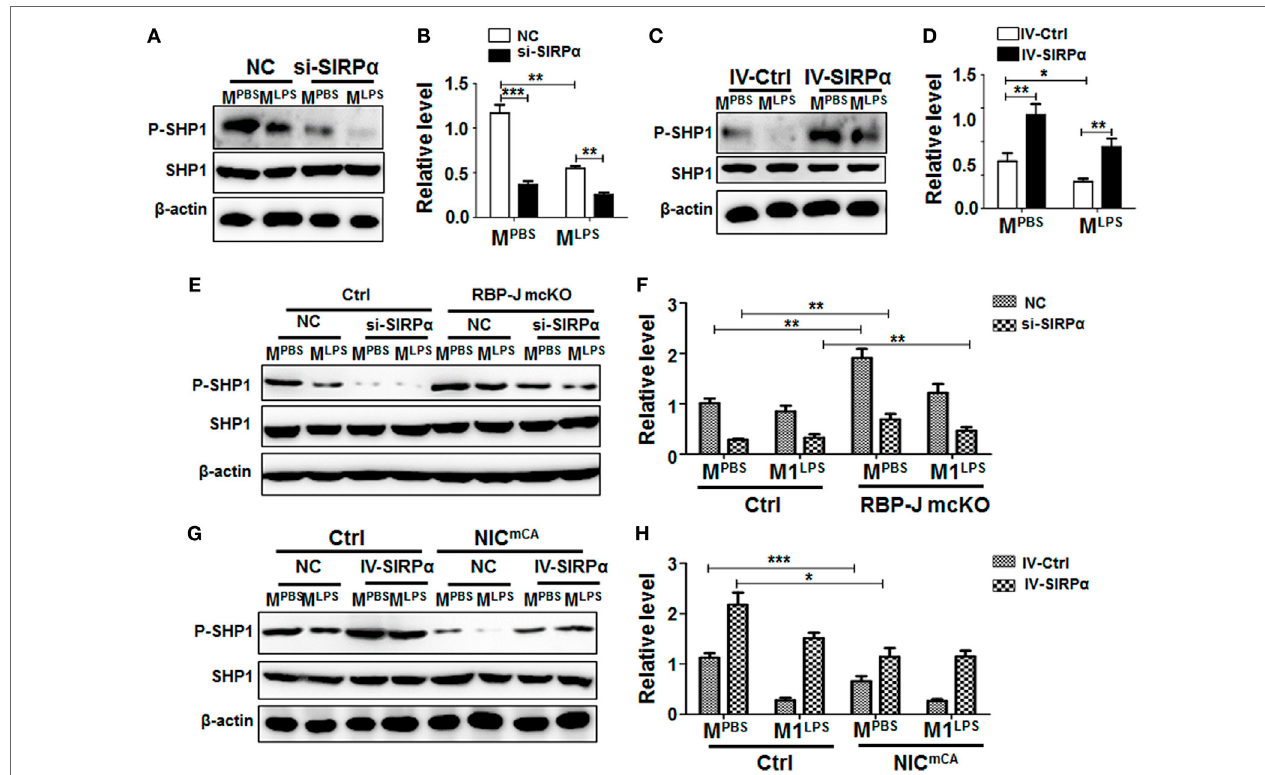
FigUre 2 | Notch signal regulated signal regulatory protein α (SIRP α ) expression and SHP-1 activation. (a–D) Bone marrow-derived macrophages (BMDMs) with SIRP α knockdown (a,B) or overexpression (c,D) were stimulated with PBS or lipopolysaccharide (LPS) + IFN γ for 24 h. Western blotting was carried out to analyze SHP-1 phosphorylation ( n = 4). (e,F) BMDMs from RBP-J deficient (mcKO) and control (Ctrl) mice were transfected with SIRP α siRNA or NC and stimulated with PBS or LPS + IFN γ for 24 h. The phosphorylation of SHP-1 was determined by Western blotting ( n = 4). (g,h) BMDMs from Notch signal activation (NIC mCA ) and control (Ctrl) mice were infected with SIRP α -overexpressing lentivirus and stimulated with PBS or LPS + IFN γ for 24 h. The phosphorylation of SHP-1 was determined by Western blotting ( n = 4). One-way ANOVA test was used for statistical analyses. Bars represent means ± SD; * or # , P < 0.05; ** or ## , P < 0.01; *** P <